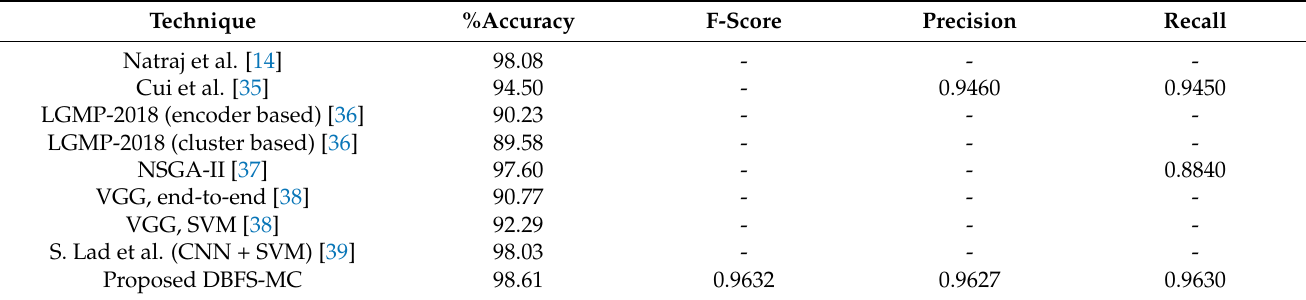
Table 9. Comparative analysis of proposed DBFS-MC with the reported